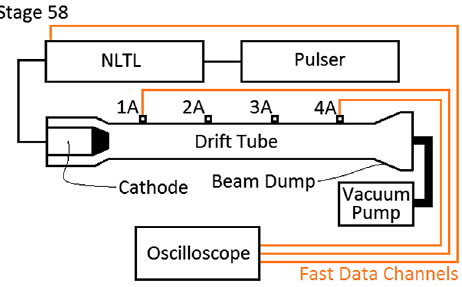
FIG. 2. Schematic of the NLTL beam driver experiment, including specified diagnostics, such as the Stage 58 D-dot, 1A — 4A B-dots, and fast data channels for sampling of rf waveform data.